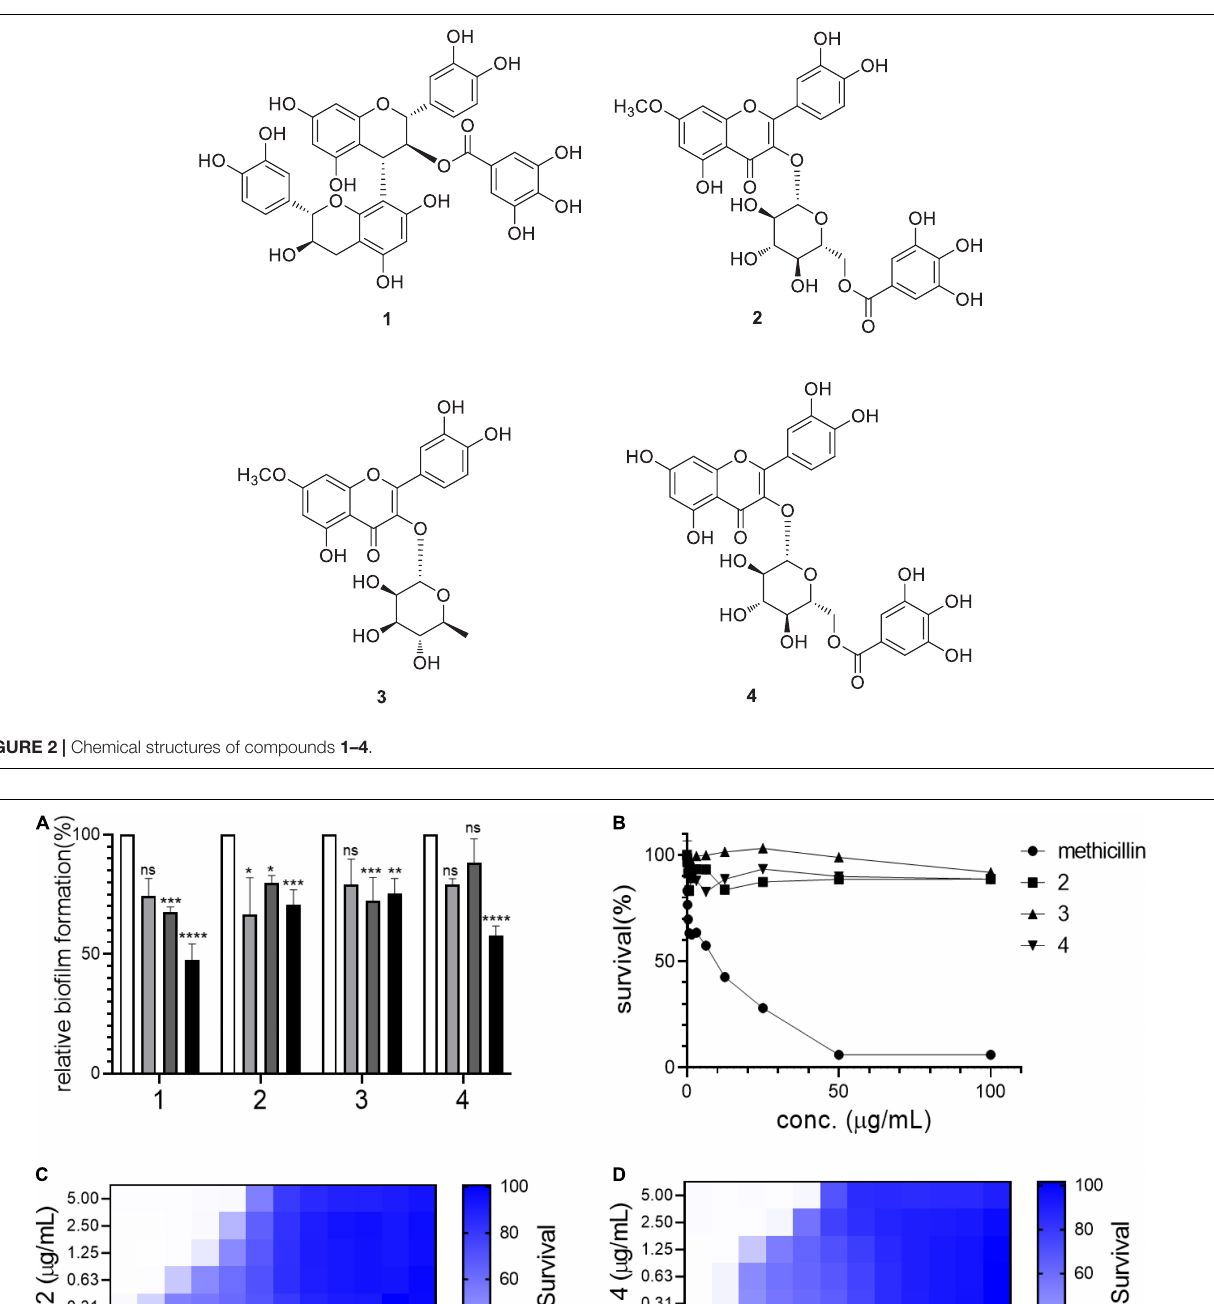
Frontiers in Microbiology |